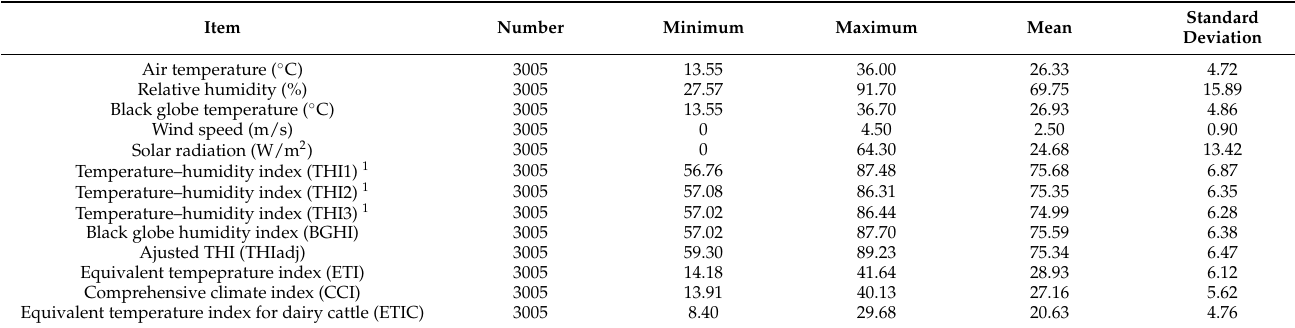
Table 1. Descriptive statistics for the environmental factors and thermal indices during this study.